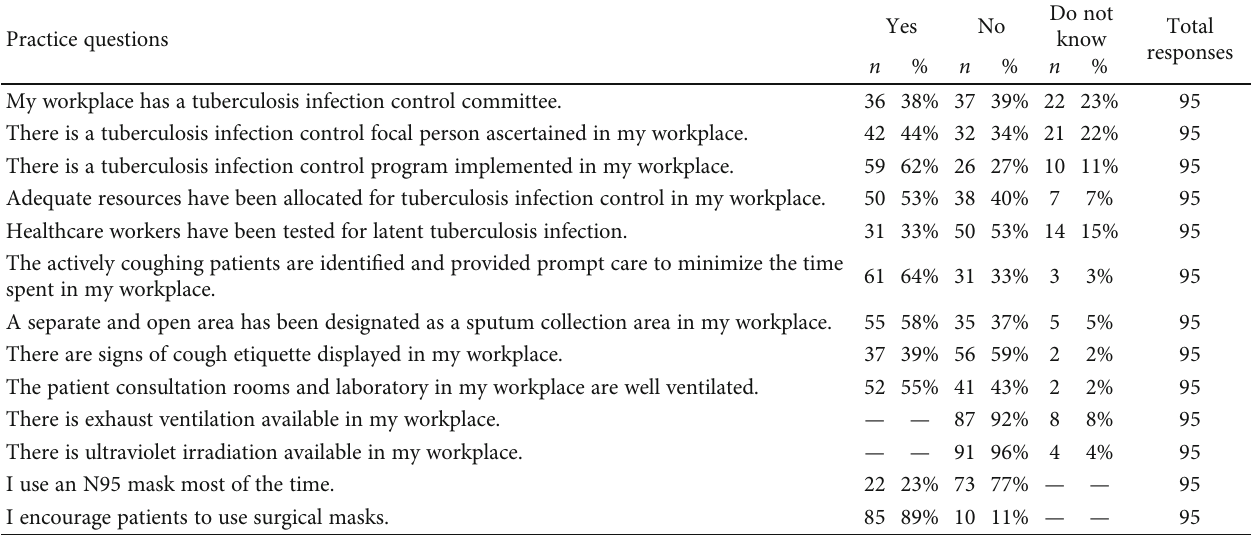
Table 4: Practice questions on drug-resistant tuberculosis infection control and the responses from the study participants. Practice